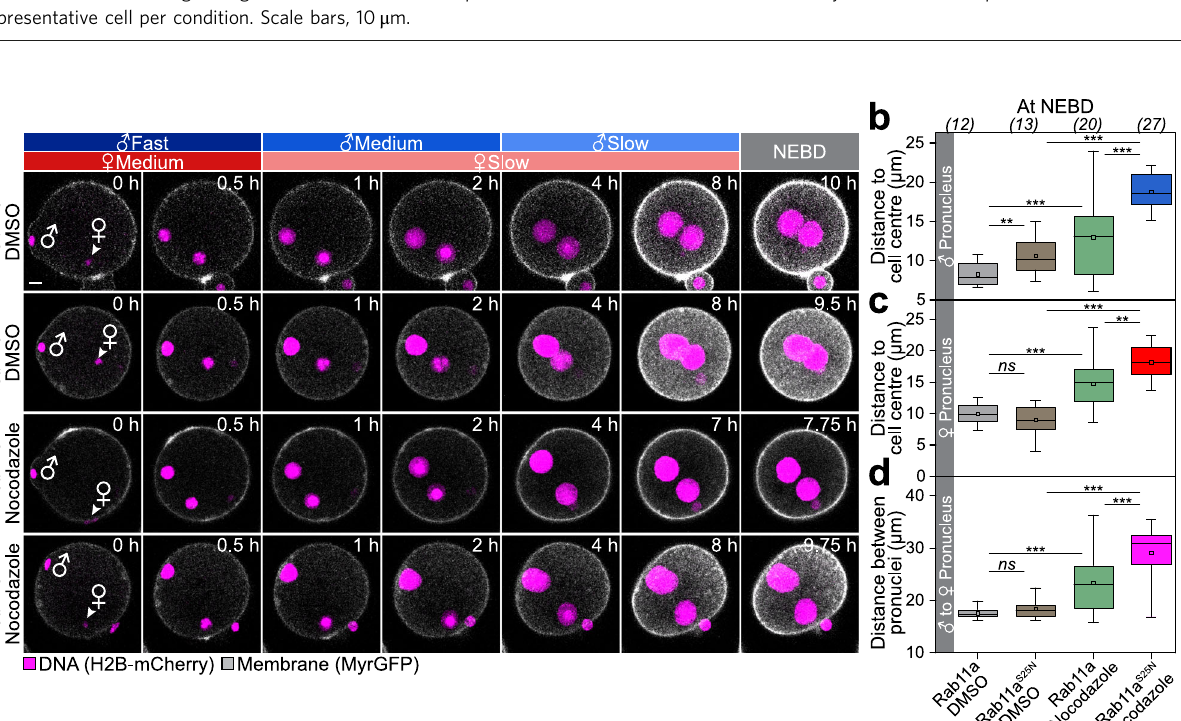
Fig. 8 Inwards-directed microtubule-based transport requires actin. a 3D time-lapse images of pronuclei and the cell surface in zygotes acutely treated with DMSO or 5 µ g/ml cytochalasin D in slow migration phase relative to time point of drug addition (0 h). Female ( ♀ ) and male ( ♂ ) genomes are shown at pronuclear formation until nuclear envelope breakdown (NEBD). Phases of respective movement speeds are classi fi ed as in Fig. 1a. The mean distance (thick line) of male ( b ) and female ( c ) pronuclei centroids to zygote centre during pronuclear migration in zygotes acutely treated with DMSO or cytochalasin D from ( a ). Total number of analyzed zygotes (italics) was pooled from three independent experiments. S.d. shown as shaded areas. Statistical plots of average velocities of male ( d ) and female ( e ) pronuclei during pronuclear migration in zygotes acutely treated with DMSO or cytochalasin D calculated from ( b ) and ( c ) with the same sample size as in ( b ) and ( c ), respectively. Statistical plots show mean ± s.d. Two-tailed Student ’ s t test was used to test for signi fi cance (from left to right: d p = 0.4, p < 0.0001, p = 0.0003 and p = 0.0004; e p = 0.7, p < 0.0001, p < 0.0001 and p = 0.0009). f Super-resolution (airyscan) images of zygotes treated with DMSO or cytochalasin D, fi xed 5 hpi and stained for F-actin with Phalloidin- Alexa488. Magni fi ed regions of the cytoplasmic actin network and the actin cortex are shown. g Super-resolution (airyscan) time-lapse images of microtubules (EMTB-mClover3, z-projection of three sections, every 1.5 µ m) in live zygotes. The magni fi ed region presented as time-lapse starting ~5.5 hpi